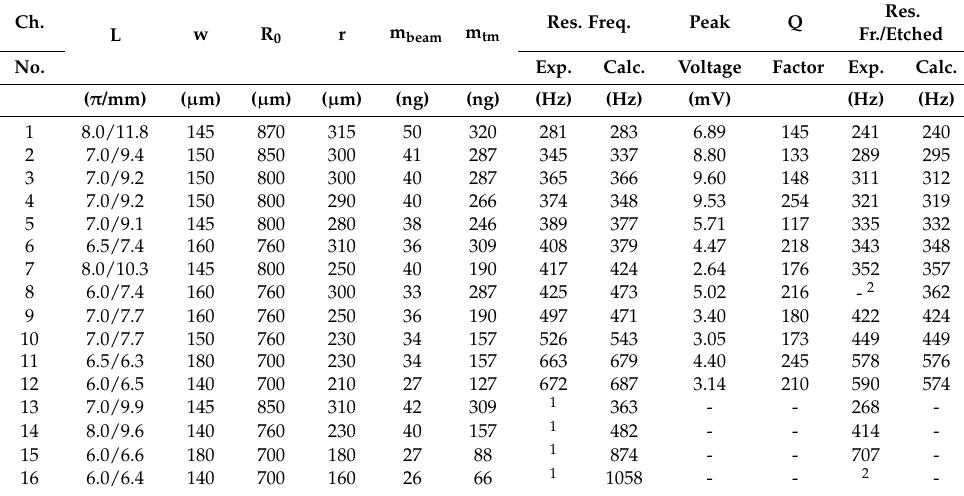
Table 1. Geometrical parameters, calculated and measured resonance frequencies, peak output voltages, quality factors for each piezoelectric cantilever, as well as the resonance frequency of uncoated spiral beam and the corresponding theoretical